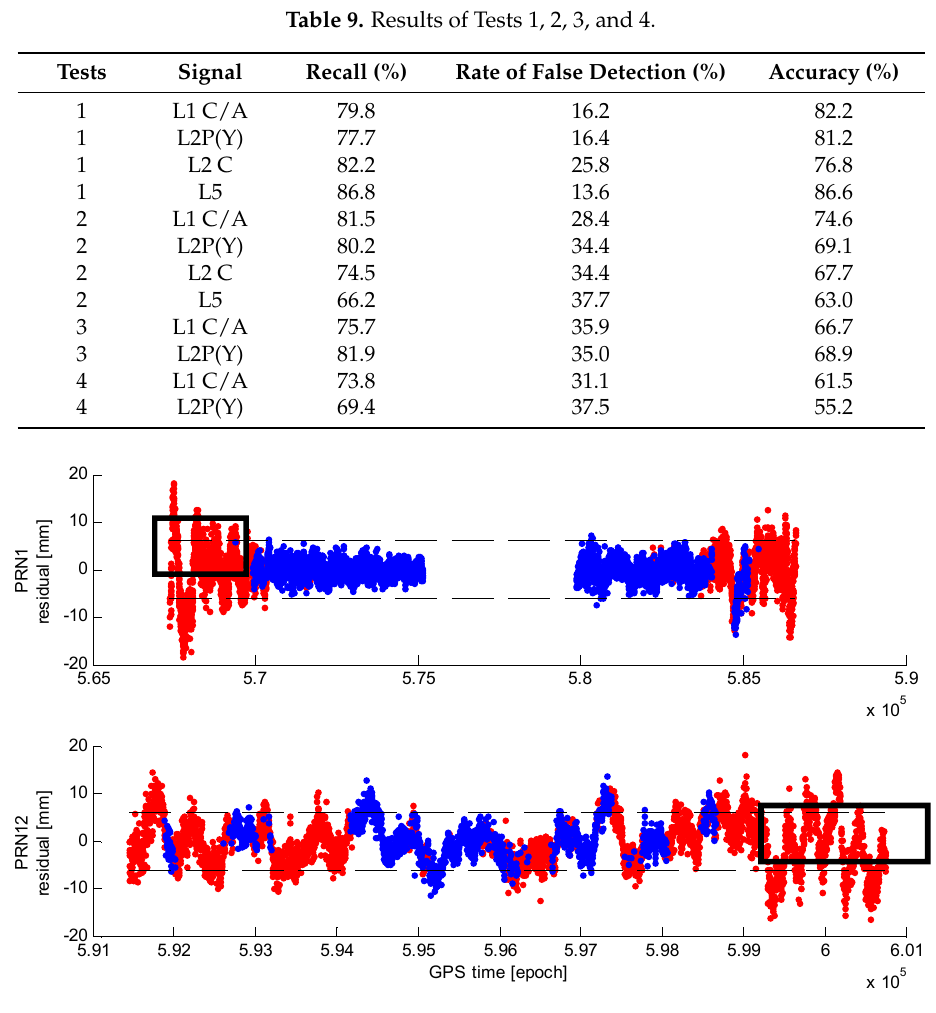
Figure 10. ‘True’ double-differenced carrier phase residuals of detected multipath measuremetns (red dots) and direct-signal only measurements (blue dots) in Dataset KTR1 (GPS L1 C/A data). Red dots in the squared areas represent mulitpath errors with small magnitudes.